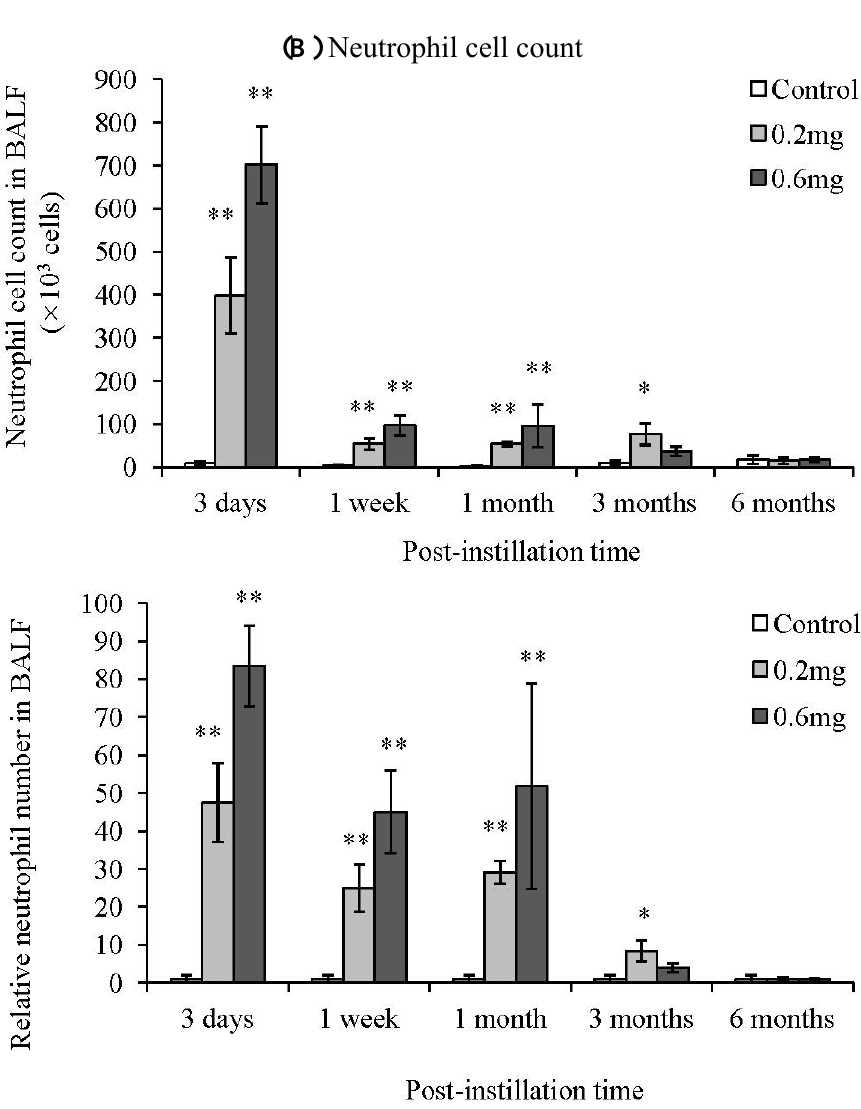
Figure 3. Cont. (B) Neutrophil cell